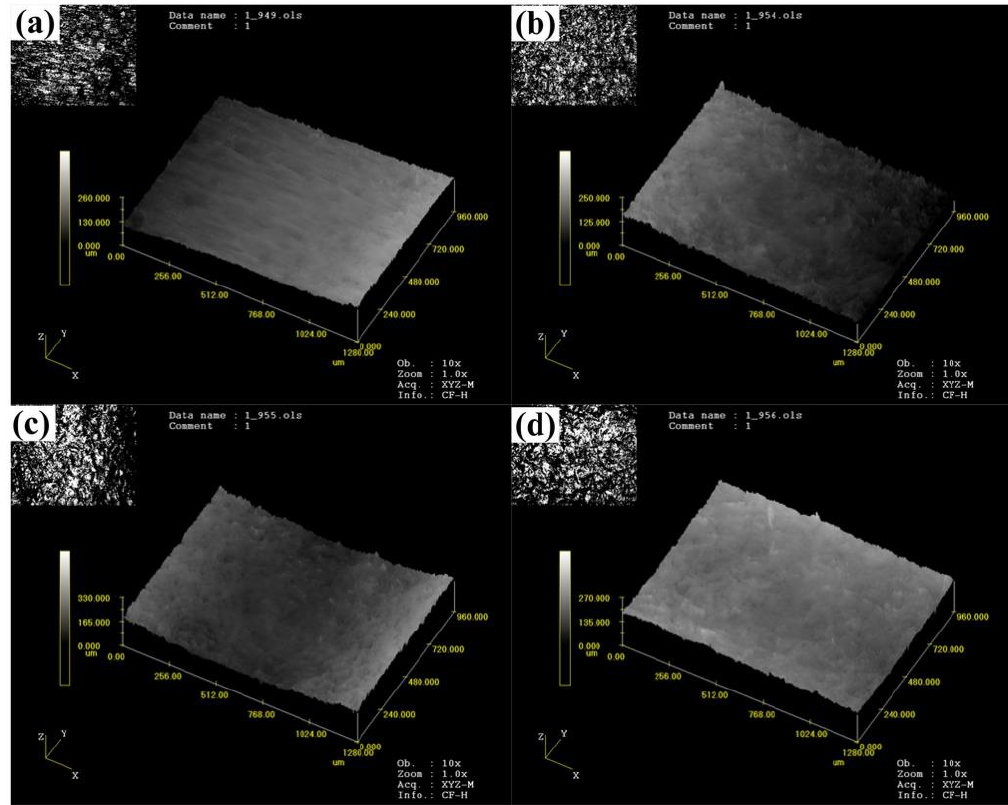
Figure 16. Three-dimensional morphology of specimens before and after shot peening: ( a ) NP specimen; ( b ) SP1 specimen; ( c ) SP2 specimen; ( d ) SP3 specimen.